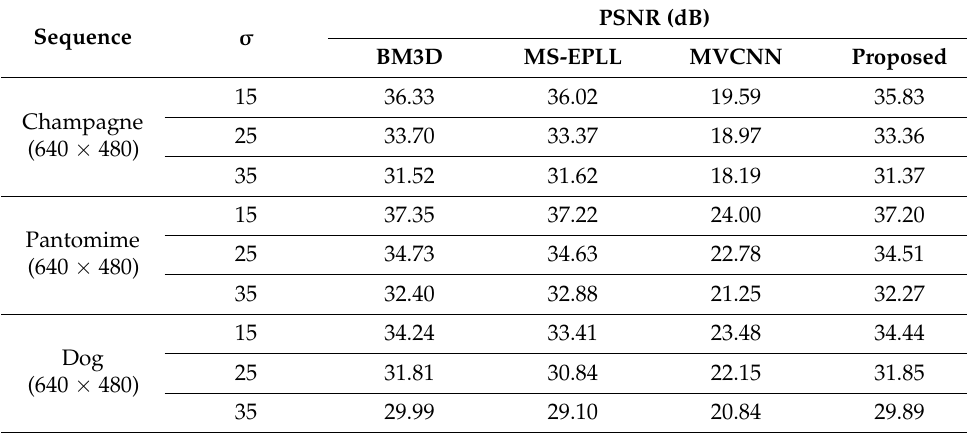
Table 4. Comparison of denoising performance for noisy multi-views (low